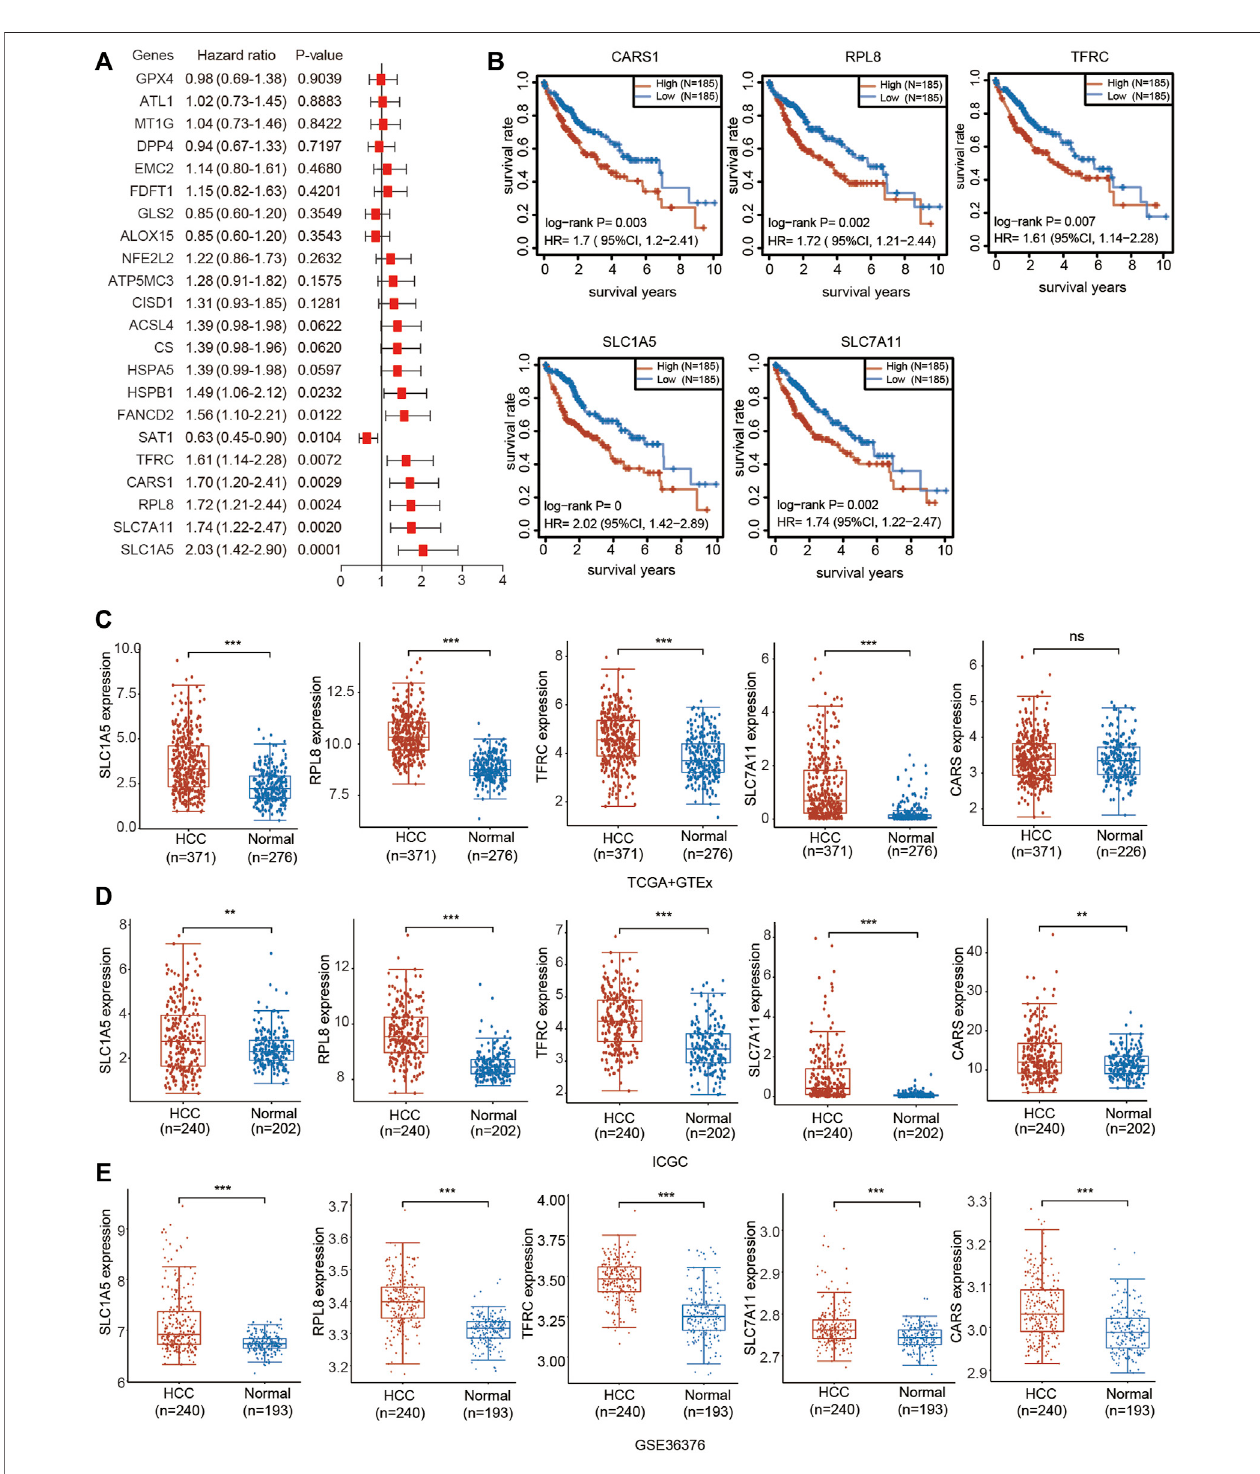
FIGURE 5 | Prognostic value and upregulated expression of fi ve FRGs. (A) Univariate Cox regression analysis of the prognostic potential of FRGs in HCC. (B) The Kaplan – Meier curves indicate the prognostic values of CARS1, RPL8, TFRC, SLC1A5 and SLC7A11 ( p < 0.05, Log-rank test). (C) Upregulated expression of CARS1, RPL8,TFRC,SLC1A5andSLC7A11intheTCGAcombined withGTExdatabases.Thedifferenceingeneexpression wascompared statisticallywiththeWilcoxontest. (D) Upregulatedexpression ofCARS1,RPL8, TFRC, SLC1A5and SLC7A11intheICGC databases.The difference ingene expression wascompared statistically with the Wilcoxon test. (E) Upregulated expression of CARS1, RPL8, TFRC, SLC1A5 and SLC7A11 in GSE36376. The difference in gene expression was compared statistically with the Wilcoxon test. * p < 0.05, ** p < 0.01, *** p < 0.001.